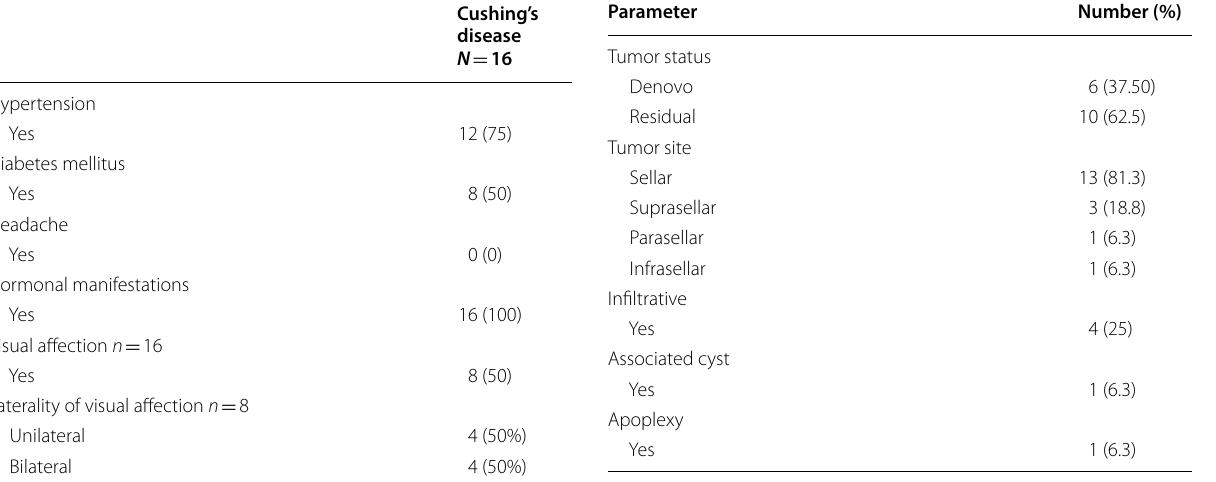
Table 1 Baseline clinical characteristics of the patients Table 2 Tumor Location and Associated findings